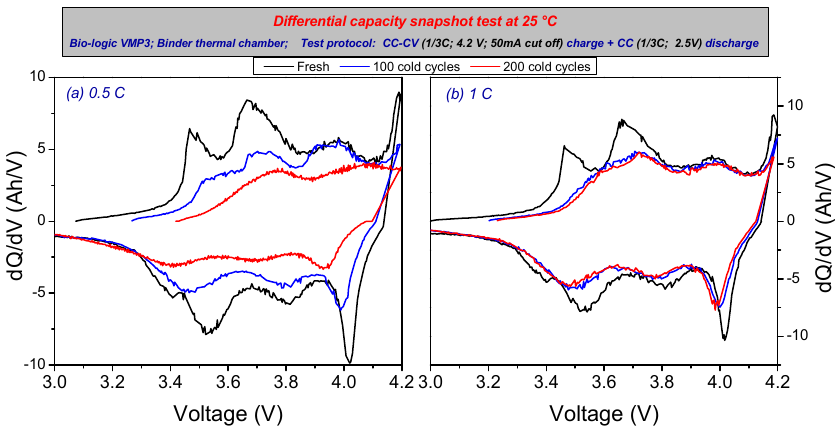
Figure 5. Snapshot results of differential capacity curves tested at 25 ◦ C and 1/3 C for batteries experiencing 0 ◦ C cold cyclings under the current rates of ( a ) 0.5 C and ( b ) 1 C.